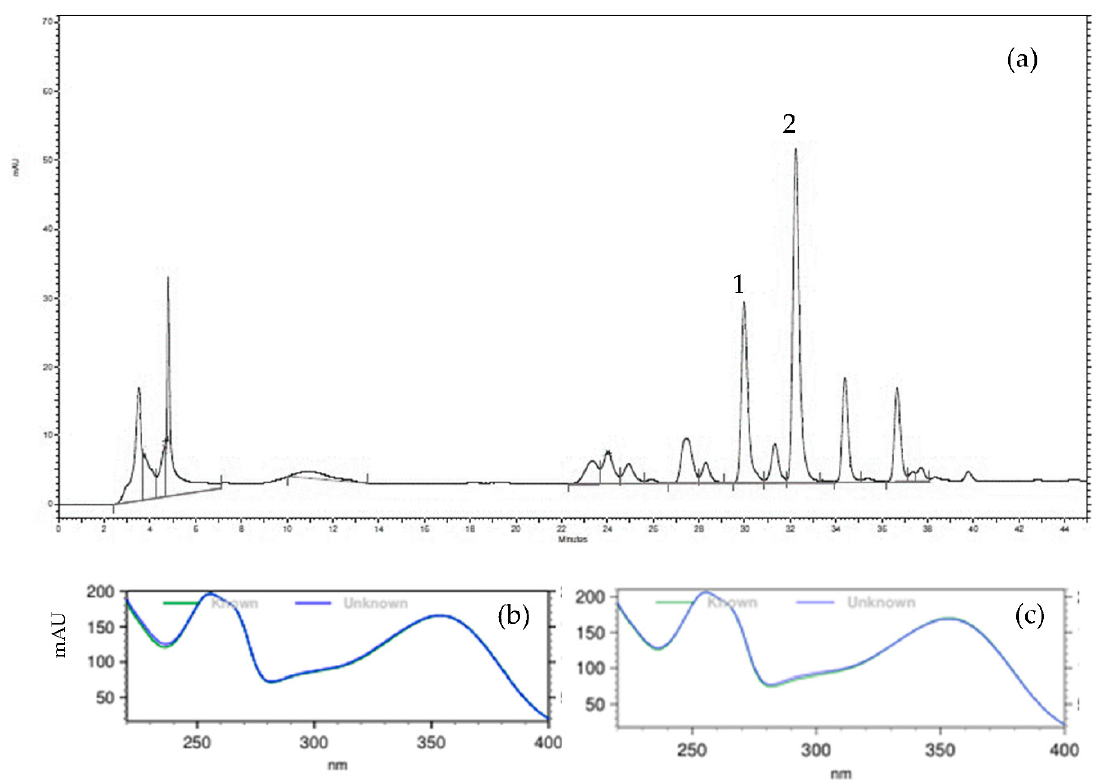
Figure 1. ( a ) Chromatogram of hydroethanolic extract of Morus nigra leaves, obtained by high performance liquid chromatography with a diode array detector (HPLC-DAD). Analysis performed by gradient elution with acetonitrile and phosphoric acid and detection at 354 nm. ( b ): spectrum of the peak 1 (“un-known” line) referring to the rutin superimposed on the spectrum of the standard (“known” line); ( c ): spectrum of the peak 2 (“unknown” line) referring to isoquercitrin superimposed on the spectrum of the standard (“known” line).